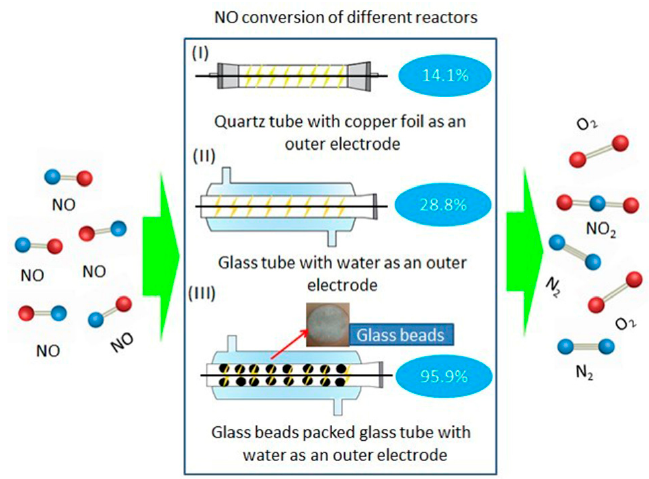
Figure 9. NO conversion under different reactors [109]; (Open Access).